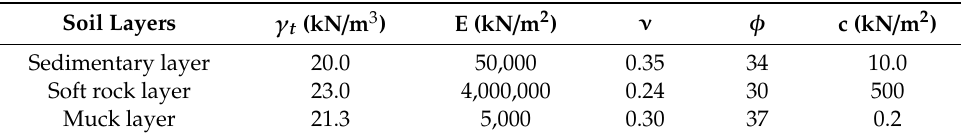
Table 4. Geotechnical parameters (Mohr–Coulomb model).